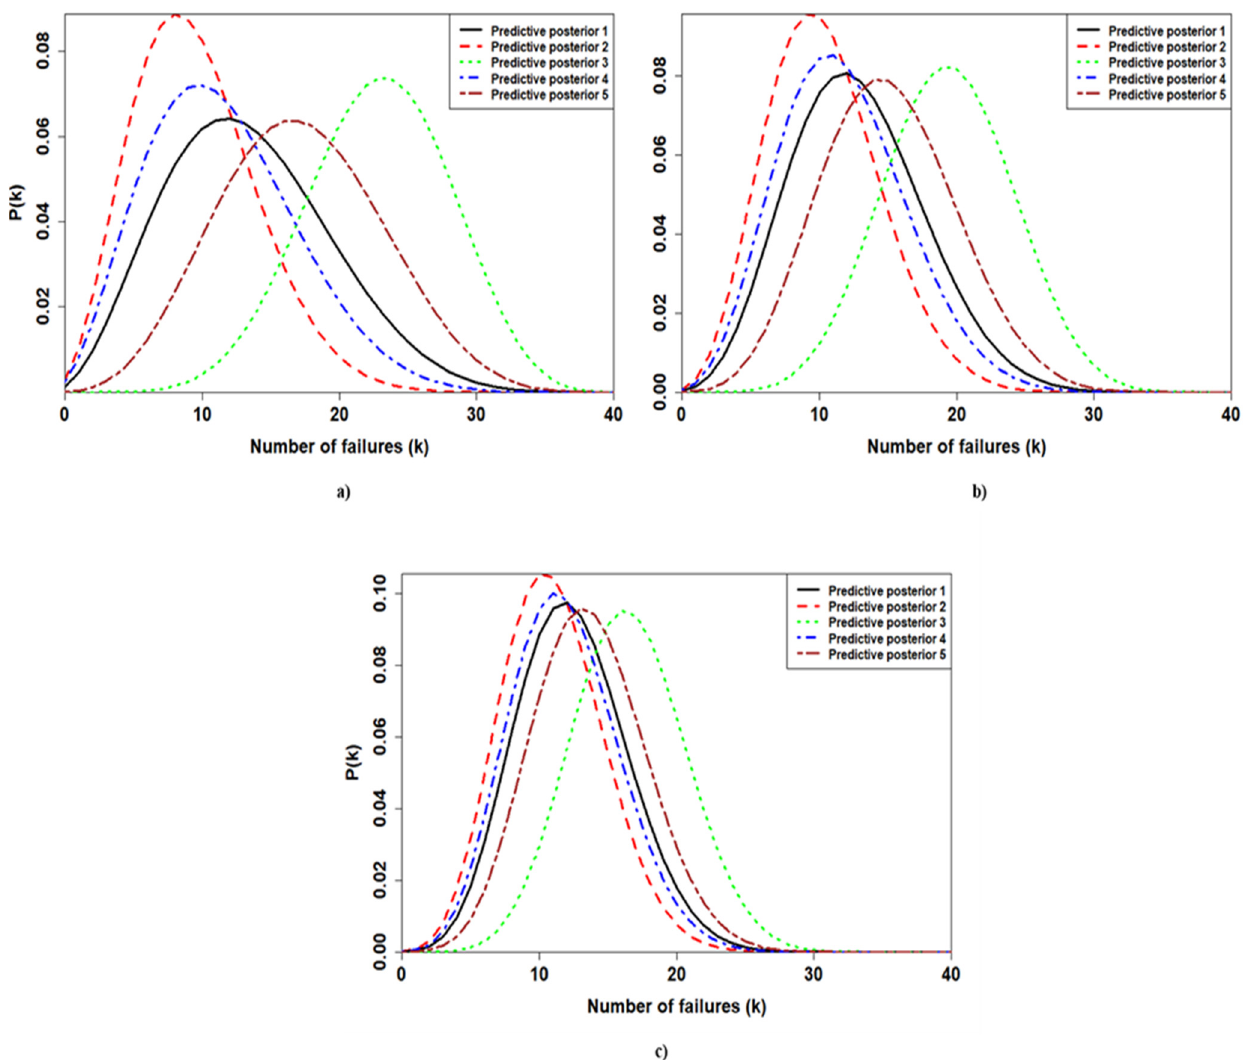
Figure 4. Beta-binomial posterior predictive distributions (PPDs) for distinct priors. ( a – c ) arise from the first application (the sample with n = 10, k = 3), the second application (the sample with n = 20, k = 6), and the third application (the sample with n = 40, k = 12), respectively. The number associated with each PPD is the same as the prior from which the PPD is generated.